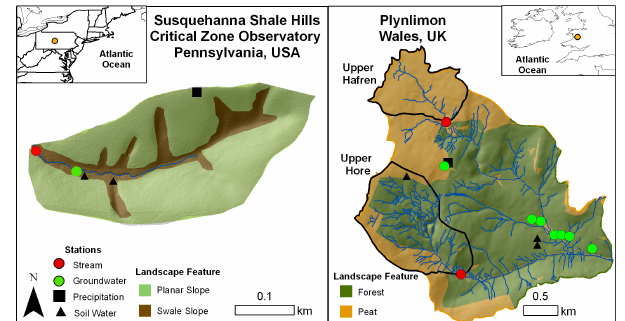
Figure 1. Map views of the Susquehanna Shale Hill Critical Zone Observatory (Shale Hills, PA, USA; left) and Plynlimon (Wales, UK; right) catchments. Symbols mark locations of precipitation (black square), stream water (red circle), pore water (black trian- gle), and groundwater (green circle) samplers. Shading delineates major landscape features that are organic rich or organic poor in each catchment: swale (brown) versus planar (light green) slopes at Shale Hills or peat (tan) versus forested (dark green) regions at Plynlimon. Notably, the most organic-rich soils are in lowlands in Shale Hills but uplands in Plynlimon; consequently, inputs from organic-rich soils dominate stream flow under low-flow conditions in Shale Hills but high-flow conditions in Plynlimon.